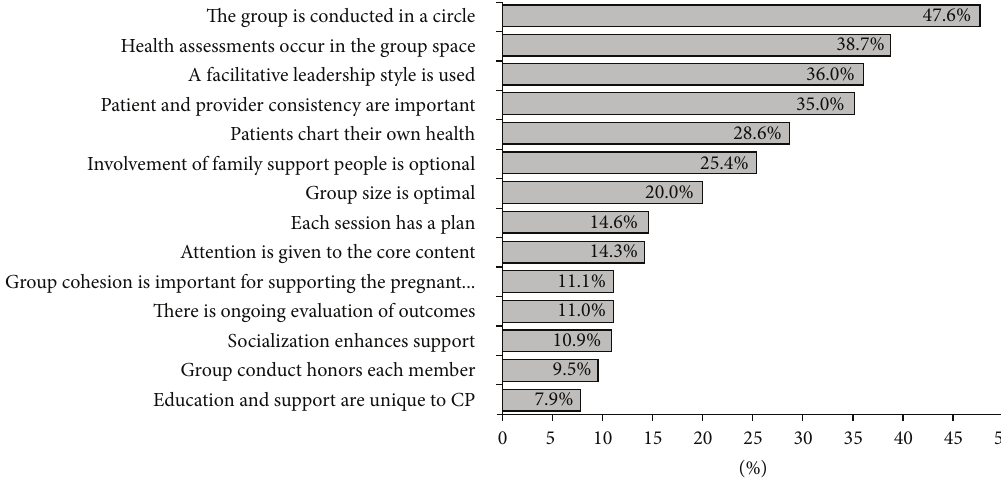
Figure 1: Learning curve: average percent improvement between time 1 and time 2 regarding essential elements.